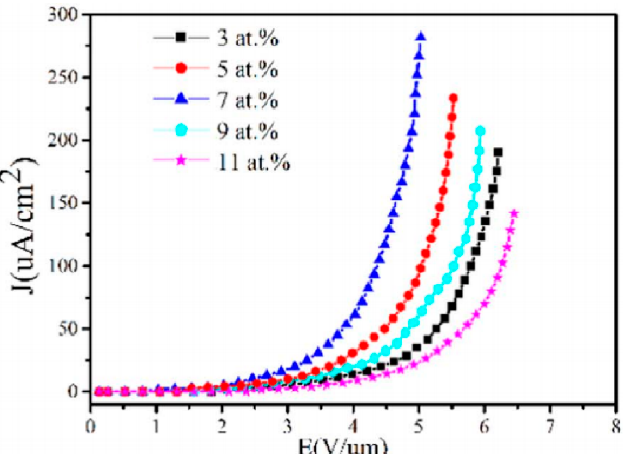
Figure 27. Field-emission characteristics of ZnO nanowires with Al doping concentration of 3, 5, 7, 9 and 11 at.%. Reproduced from [31], with the permission of Elsevier, 2018.